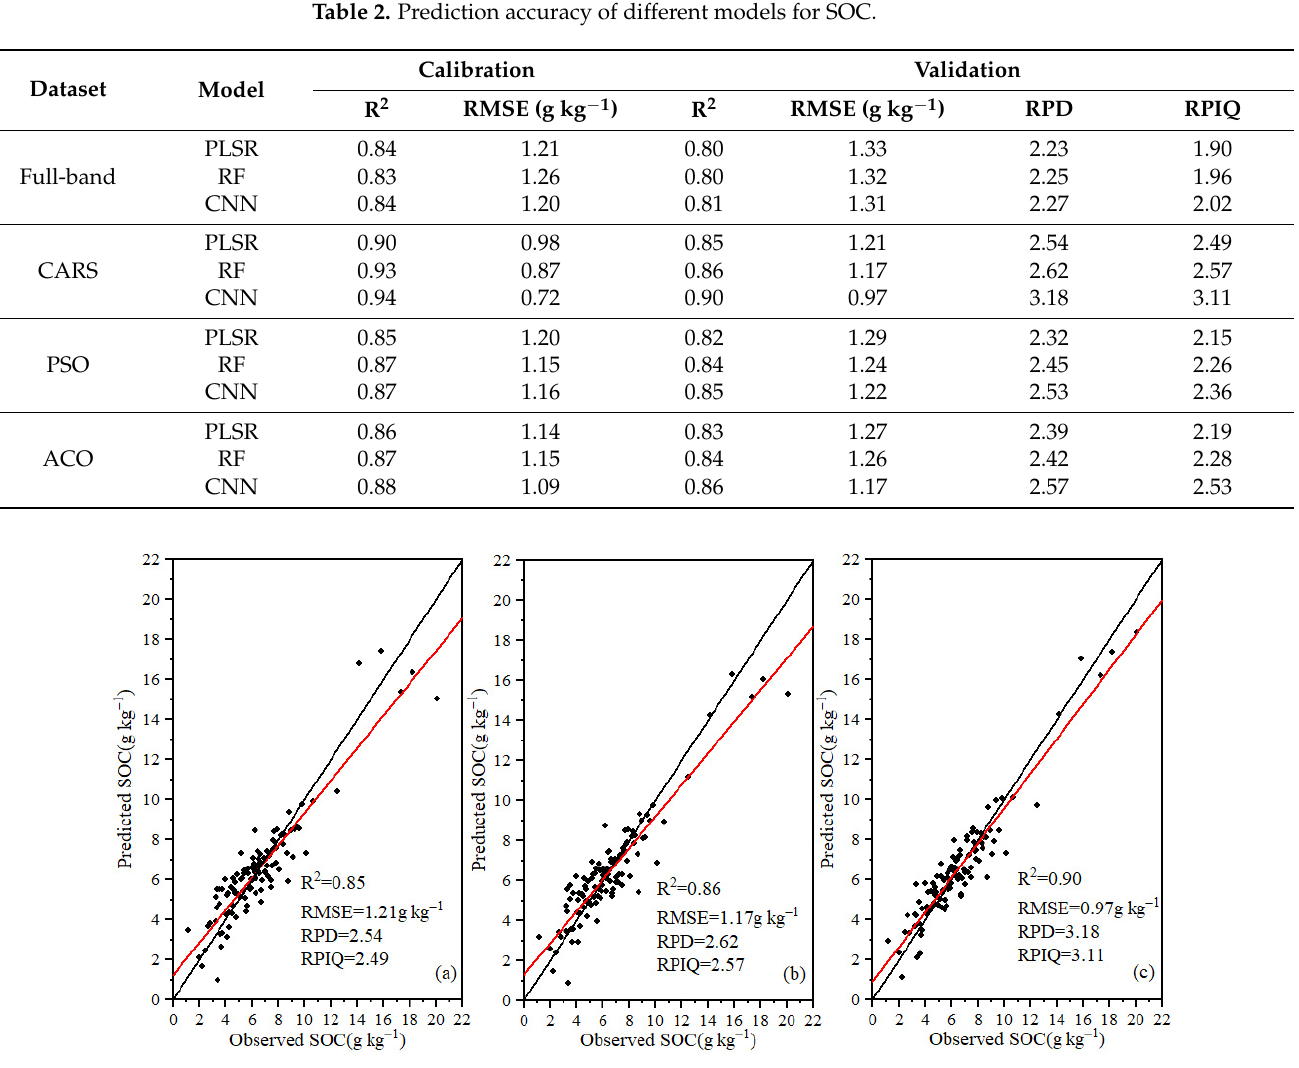
Figure 5. Scatter plots of SOC content estimates using PLSR ( a ), RF ( b ), and CNN ( c ) models built with feature bands selected by CARS